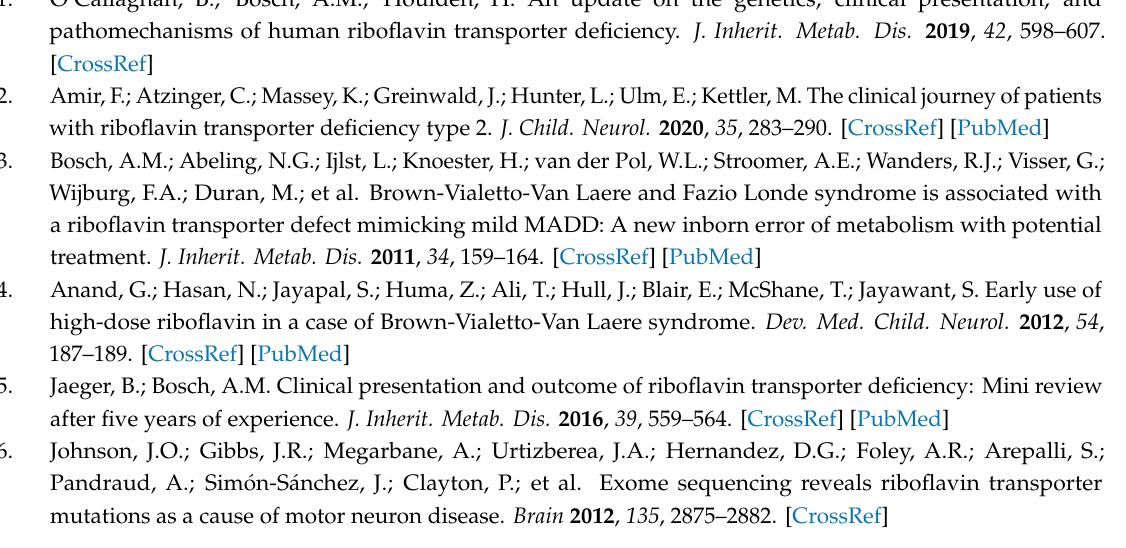
Figure S1: Immunofluorescence to SMI-32 (green) and β III-TUB (red) antibodies, showing dramatic di ff erences in neuronal morphology of riboflavin transporter deficiency (RTD) motor neurons (MNs) vs. Ctrl MNs. Confocal analysis show a patchy distribution in RTD cells, as opposed to the filamentous appearance in healthy neurons. Nuclei are stained with Hoechst